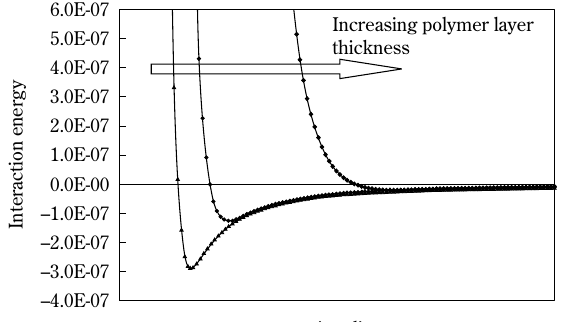
Fig. 2 Energy as a function of separation distance for the interaction of two spherical particles in the presence of a polymer coating on each particle. For simplicity, no electrical double layer interac- tions are included and the data shown is simply the summation of a steric polymer interaction and the van der Waals interaction. The three data sets shown correspond to an increasing thick- ness of the adsorbed polymer